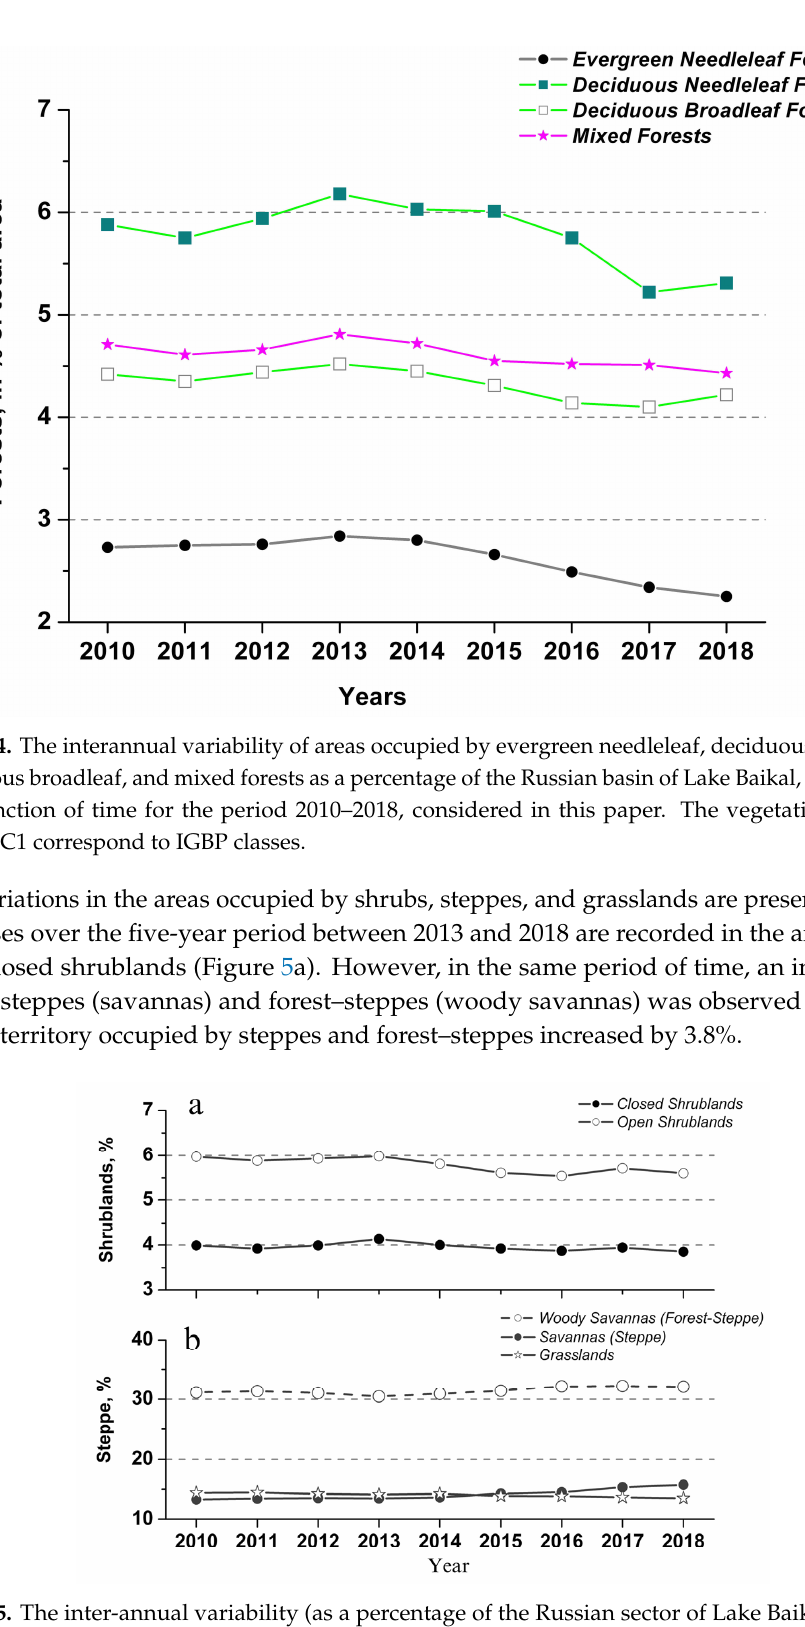
Figure 5. The inter-annual variability (as a percentage of the Russian sector of Lake Baikal basin) of areas occupied by open and closed shrublands ( a ) and forest-steppe / steppe / grassland ( b ), as a function of time. The vegetation types in MCD12C1 correspond to IGBP